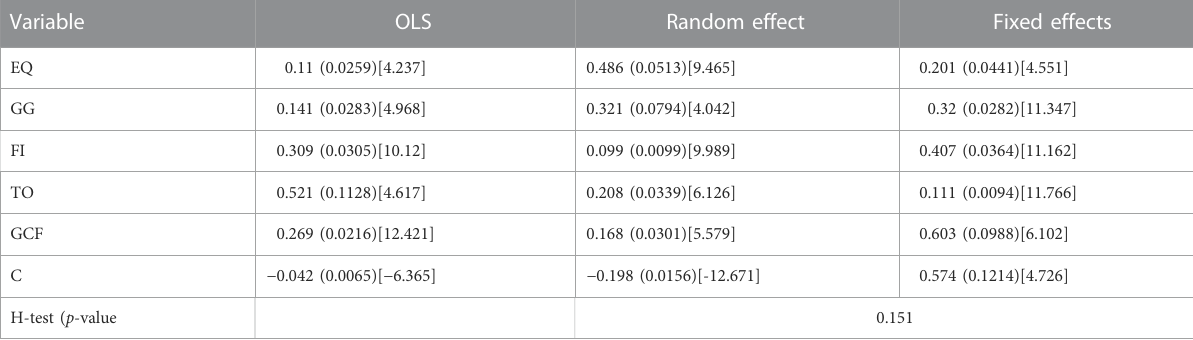
TABLE 6 Baseline estimation: fi nancial inclusion, fi nancial ef fi ciency, and foreign capital in fl ows. Variable